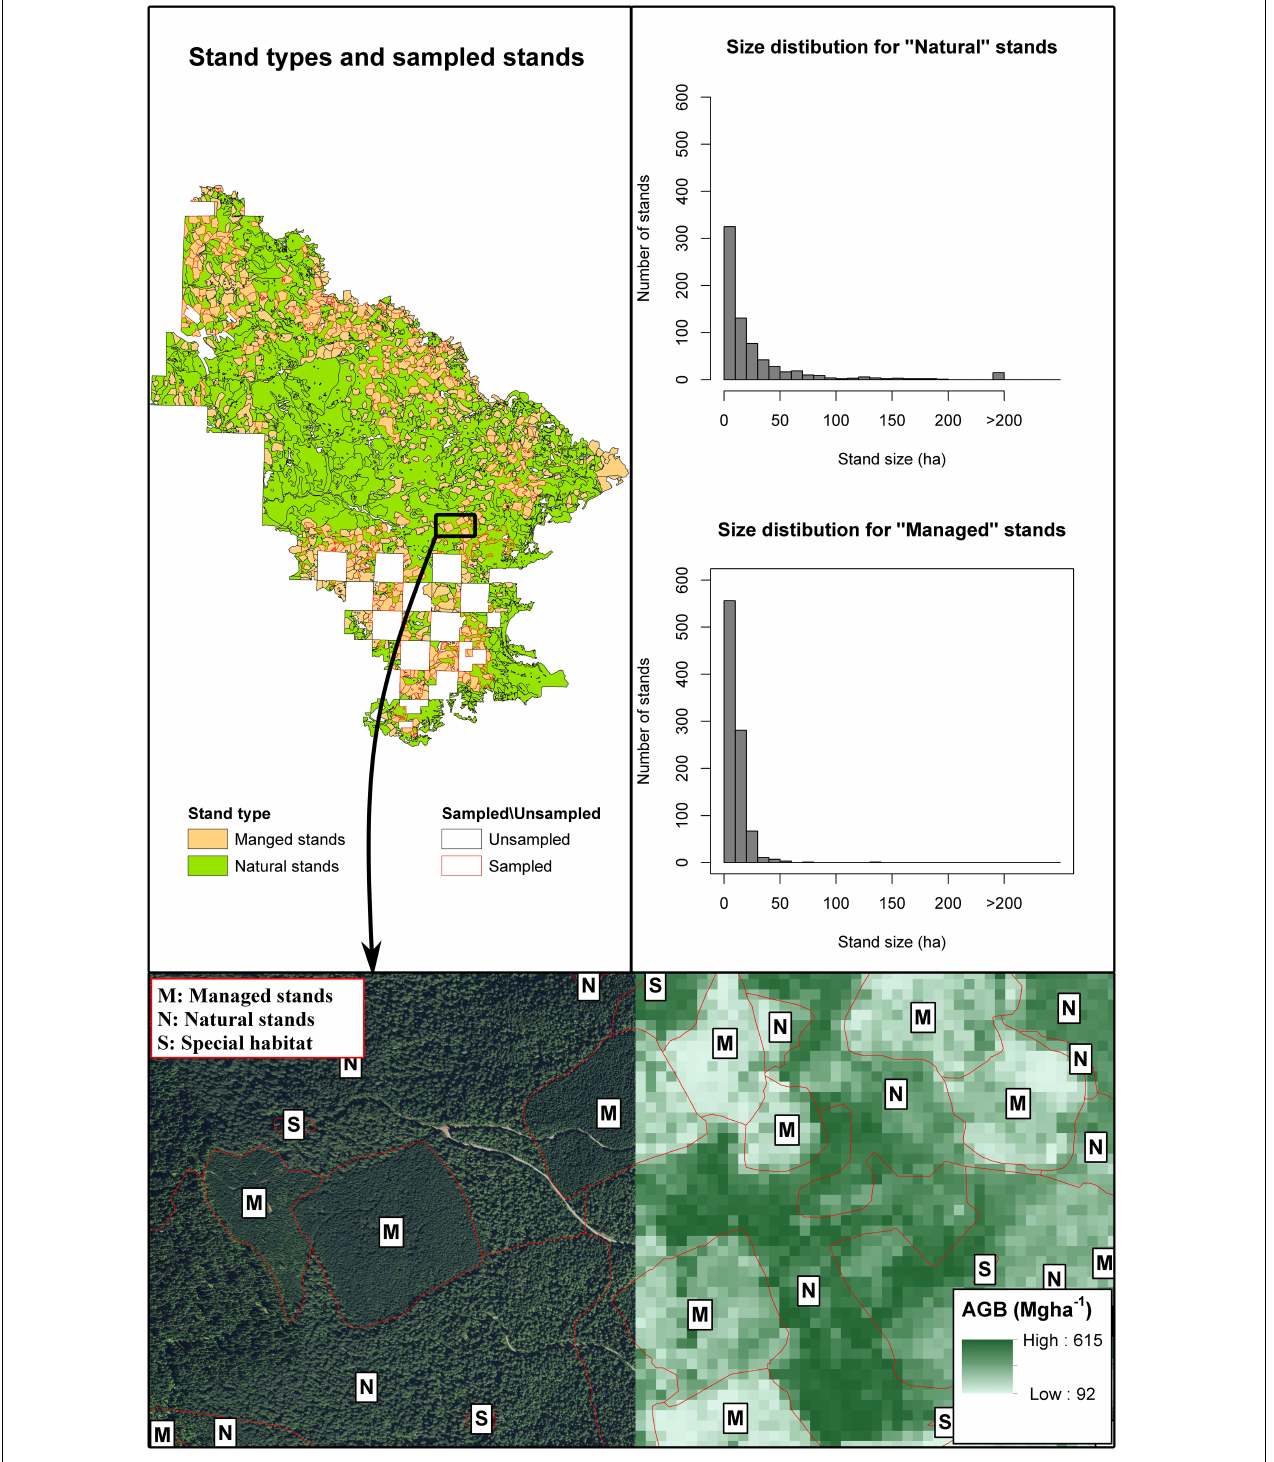
FIGURE 2 | Upper left panel displays the location of natural and managed stands. Upper right and middle right panels display the size distribution within the study area for natural and managed stands, respectively. Bottom panel, sampled area showing the orthophoto on the western side and the CMS AGB map on the eastern side of the image. Managed stands are labeled with the letter M, natural stands are labeled with the letter N, and special habitat areas (small size non-forested polygons within stands) are labeled with letter S.